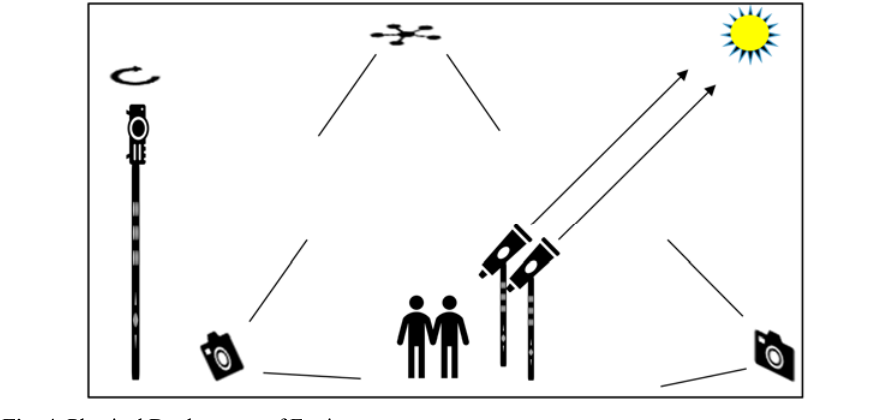
Fig. 4. Physical Deployment of